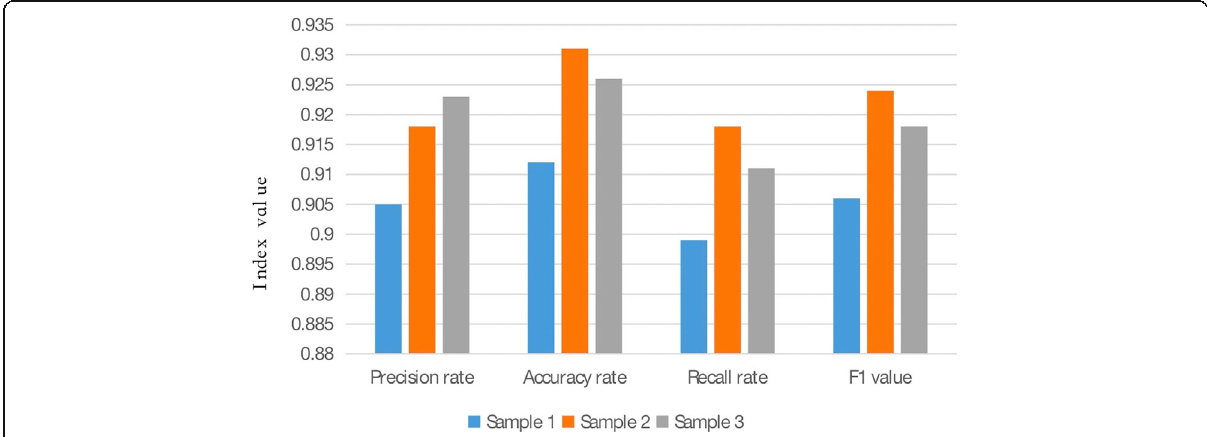
Fig. 7 Histogram of test results of performance